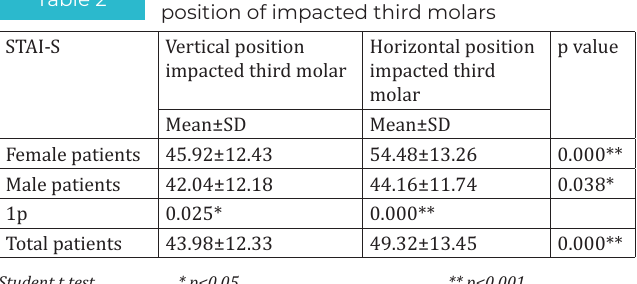
STAI-S scores, relationships with anxiety and position of impacted third